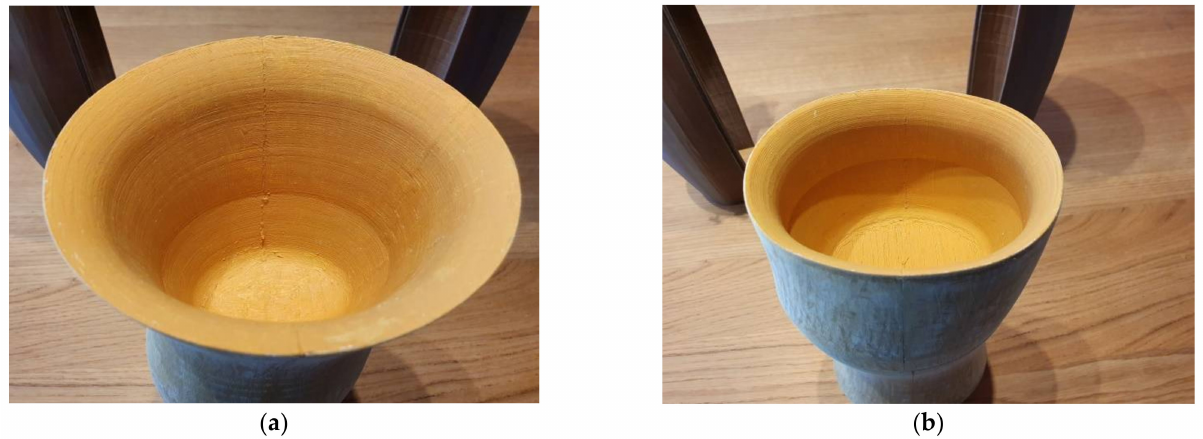
Figure 4. 3D print of the reconstructed Capua leg, wooden core: ( a ) Looking into the upper part; ( b ) Looking into the lower